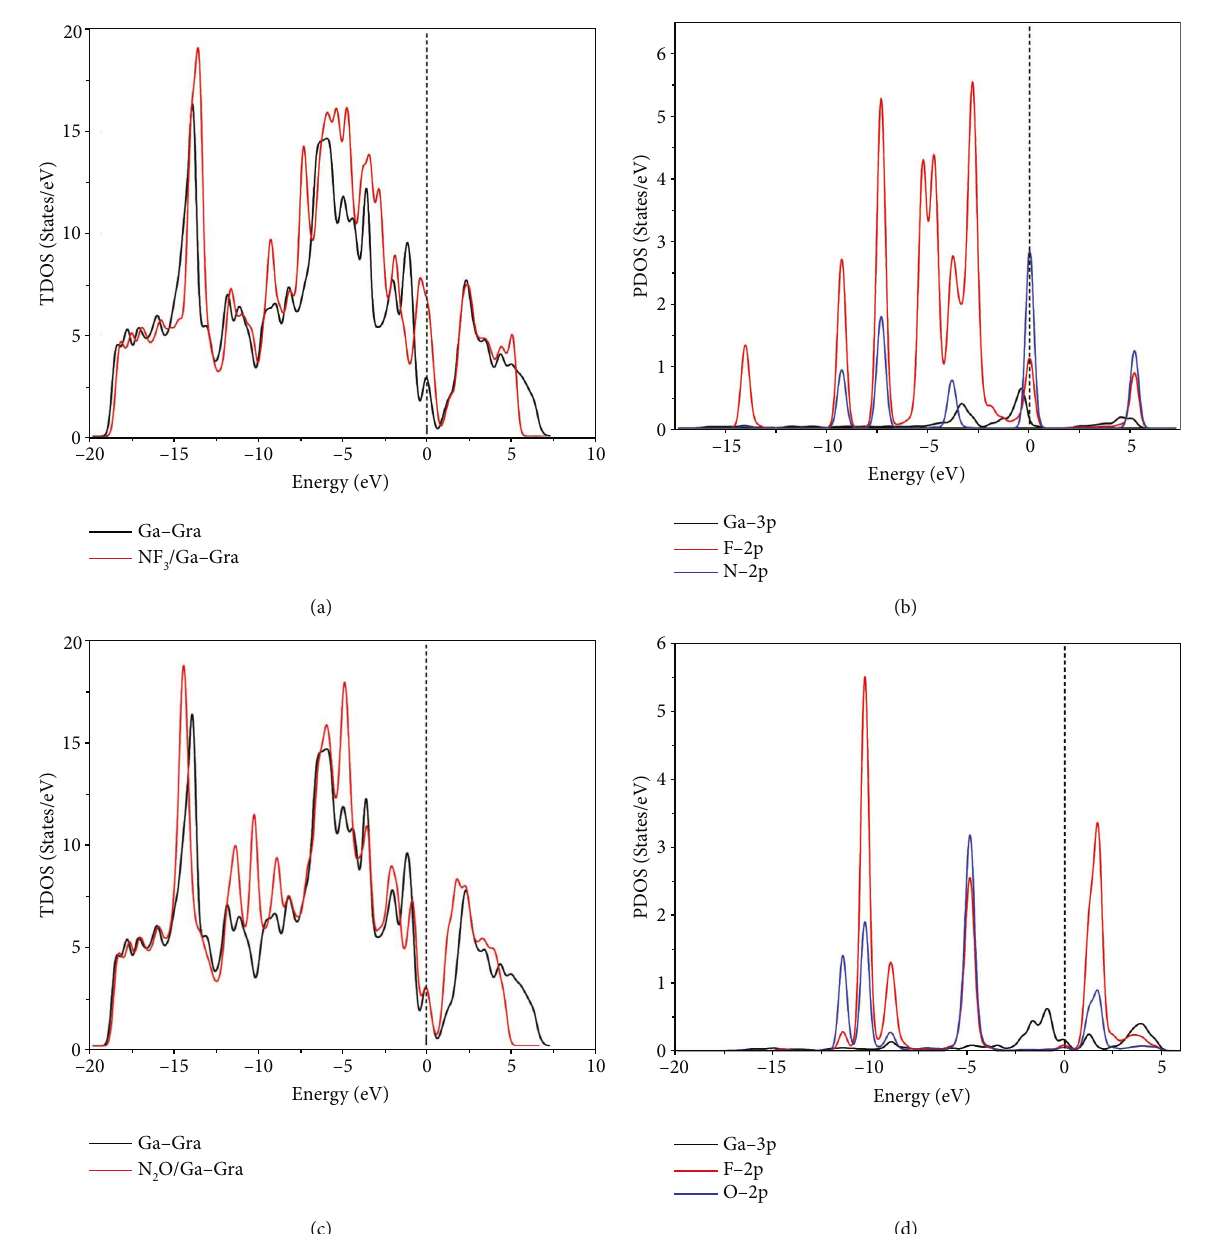
Figure 14: The density of states con fi guration of NF (d) N 2